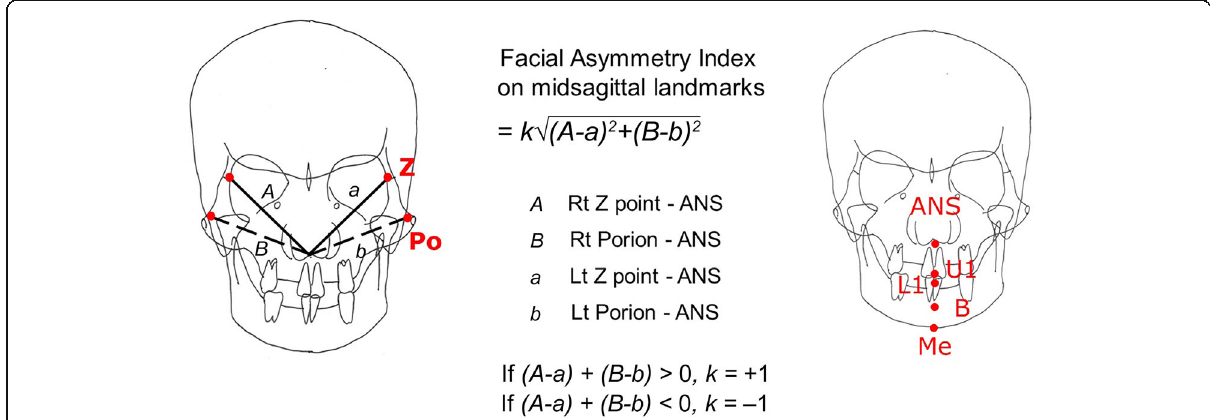
Fig. 3 Calculation of facial asymmetry index on ANS. The differences of distances between 2 reference points — frontozygomatic suture point ( Z point) and porion (Po) — and ANS were measured. The sum of the square value of each difference was obtained, and we defined the root value of the sum was defined as facial asymmetry index on the midsagottal landmarks. If ANS was on the true midsagittal plane, the facial asymmetry index indicated